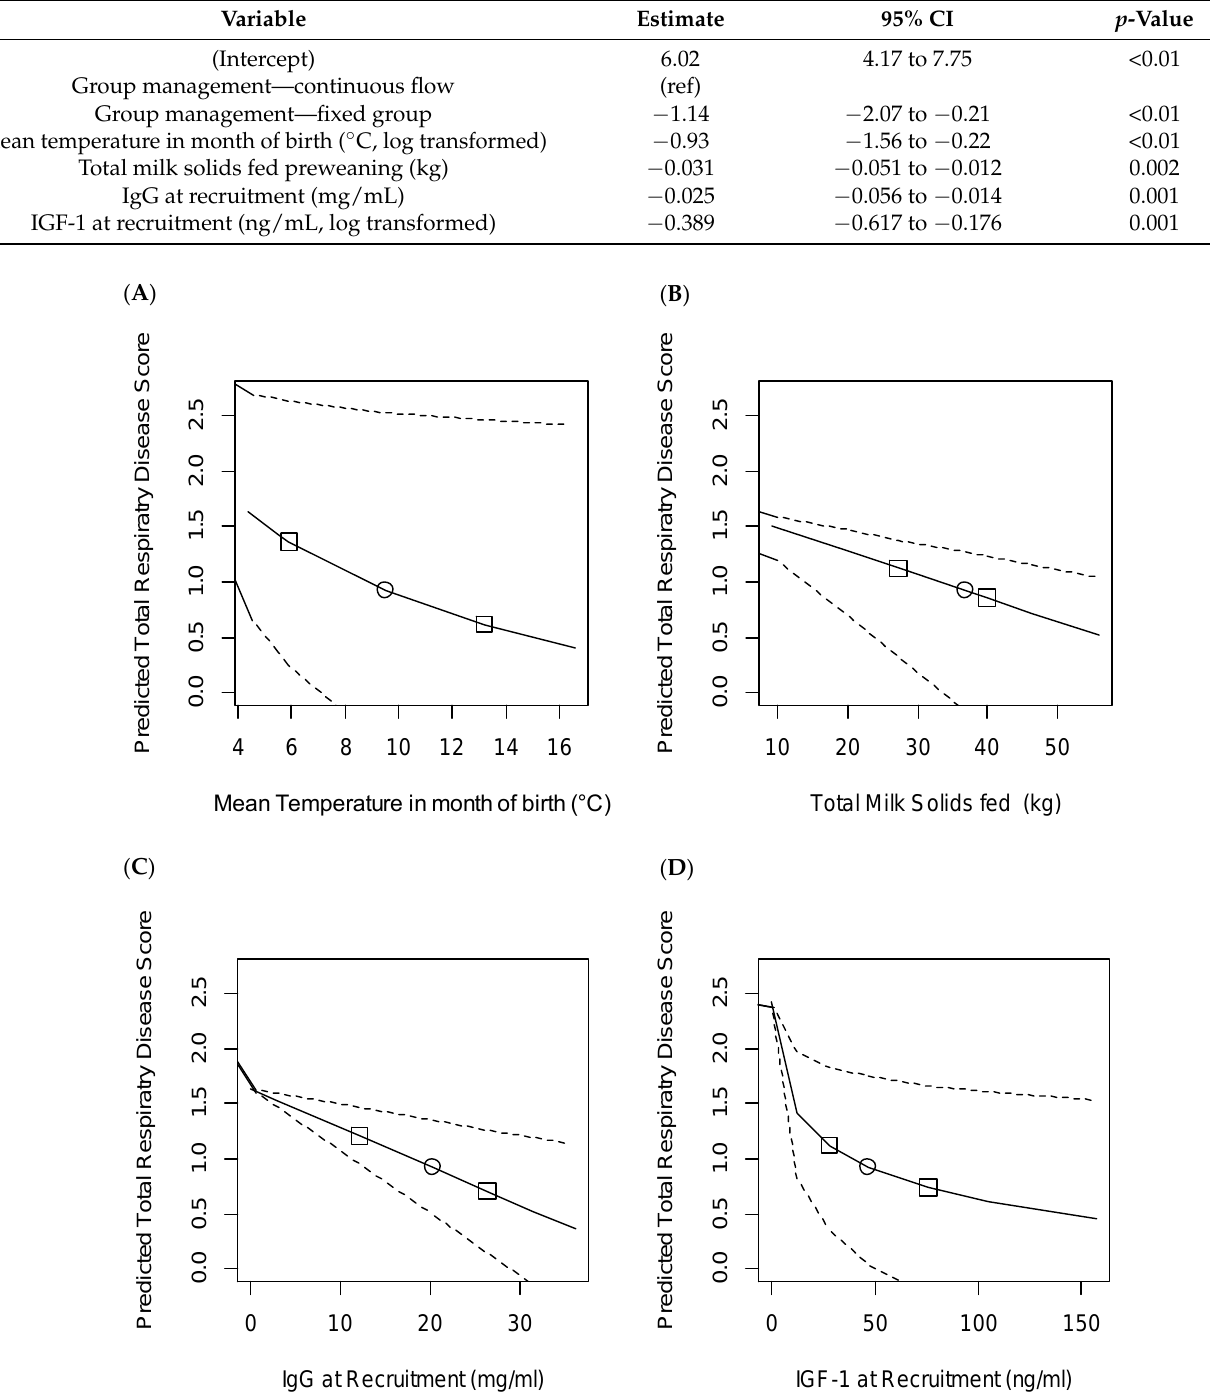
(cid:35) median value, (cid:3) 25th and 75th